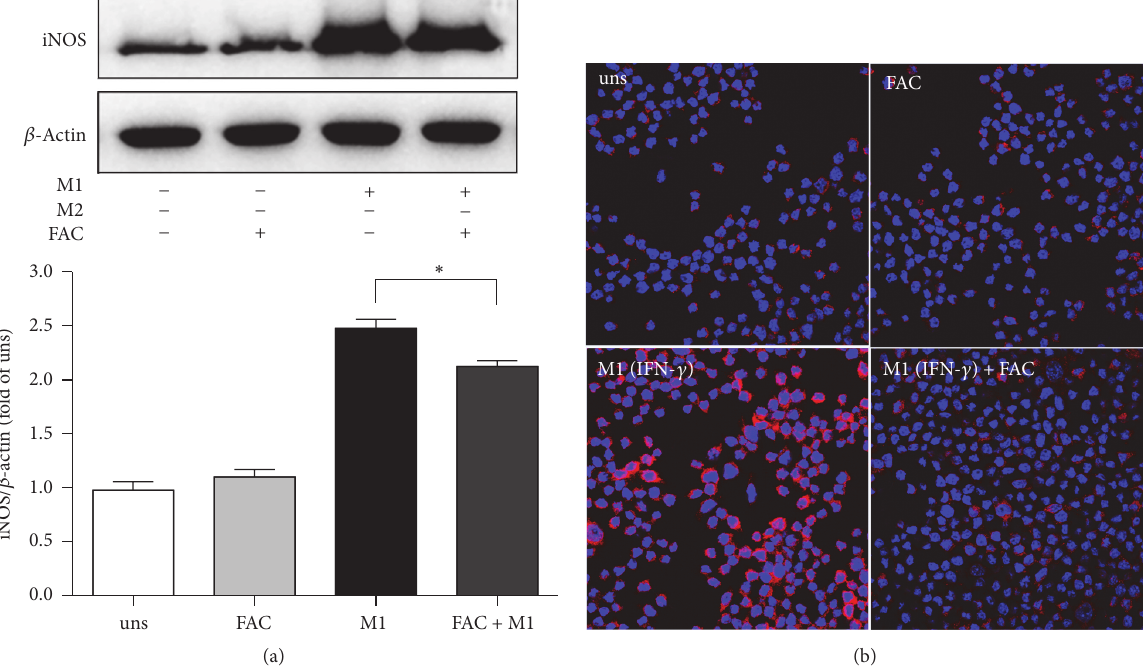
Figure 4: Effects of iron on iNOS expression in M1 macrophage. RAW264.7 macrophage cells were incubated with the stimulus, either FAC, IFN- 𝛾 , or no stimulus for 24 h. Cells were harvested and analyzed for iNOS (a) by western blot or fixed and stained with antibodies for iNOS (b). Protein expression is represented as fold-change compared to unstimulated macrophages. In each sample group, cell was stained with the red fluorescent-labeled antibody for the targeted protein and the blue fluorescent-labeled DAPI for nucleus. Data are representative images of three (a) or two (b) independent experiments. (uns: unstimulated macrophages; ∗ 𝑝 < 0.05 ).